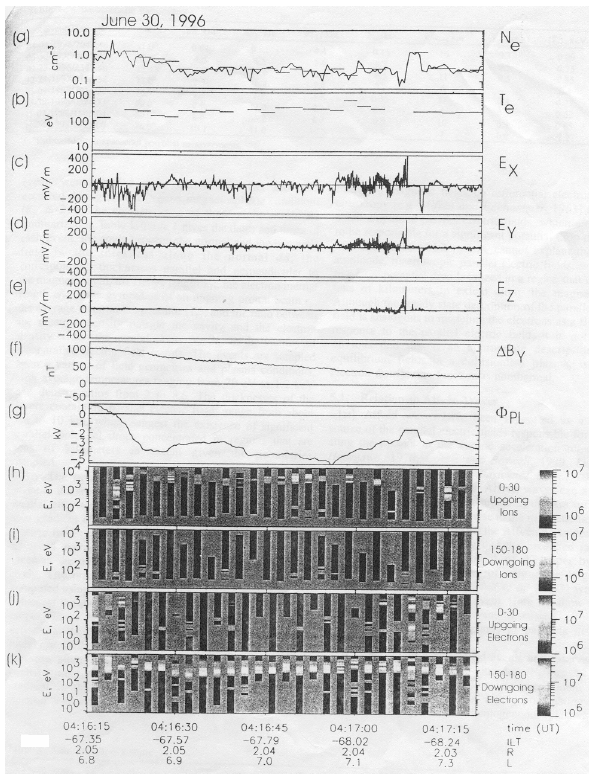
Fig. 3. Southern auroral zone crossing near dusk on 30 June 1996 (Hull et al.,